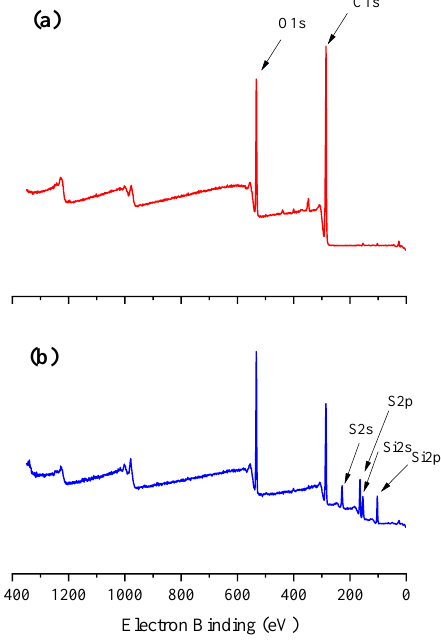
Figure 1. Comparison of the FTIR spectra of: NF WJF (red) and SH WJF (black). ν stands for stretching band.